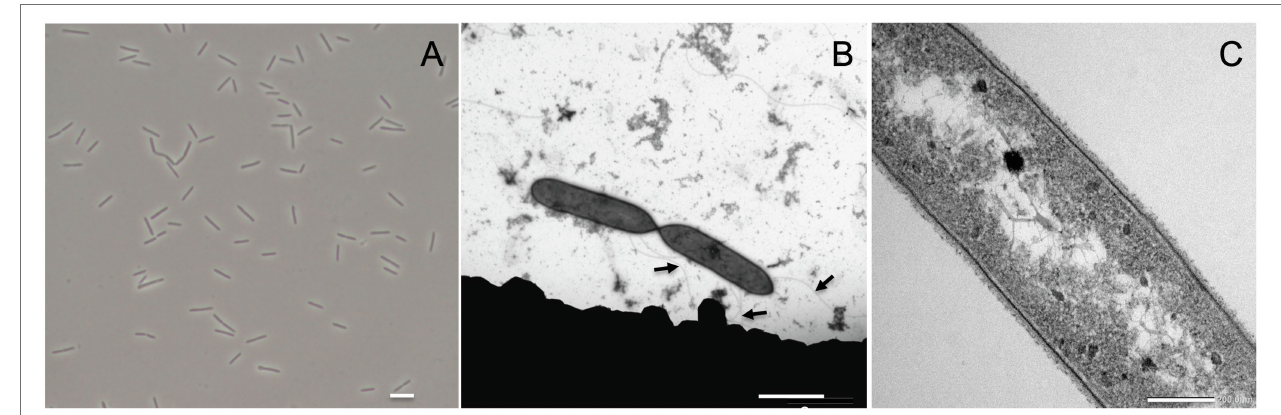
FIGURE 1 | Acididesulfobacillus acetoxydans gen. nov. sp. nov. strain INE microscopy images: (A) phase contrast microscopy and (B,C) transmission electron microscopy. Scale bars represent 5 mm, 2 mm, and 200 nm, respectively. Arrows in (B) indicate